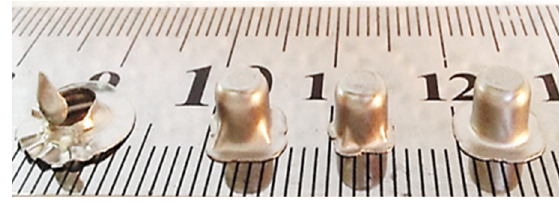
Fig. 13. Physical micro formed cups.